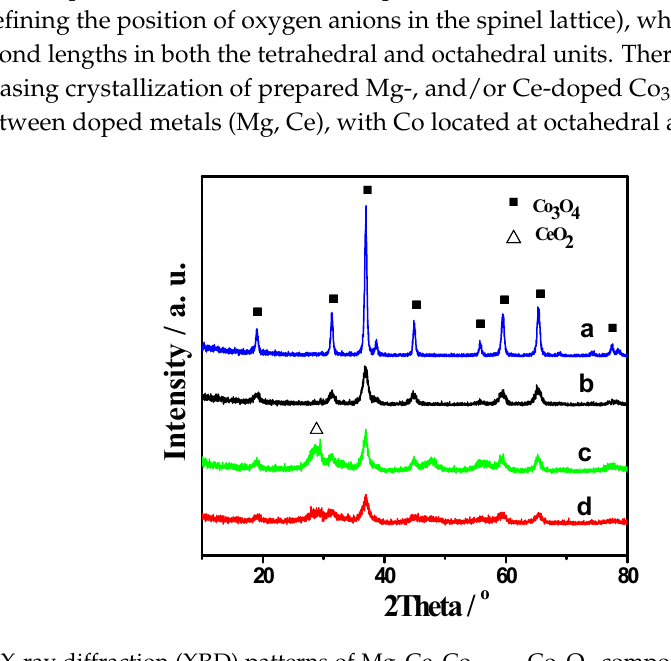
Figure 1. X ‐ ray diffraction (XRD) patterns of Mg x Ce y Co 1 − x − y Co 2 O 4 composite spinel metal oxide: ( a ) Co 3 O 4 ; ( b ) Mg 0.2 Co 0.8 Co 2 O 4 ; ( c ) Ce 0.05 Co 0.95 Co 2 O 4 ; ( d ) Mg 0.025 Ce 0.05 Co 0.925 Co 2 O 4 . Table 1. Brunauer–Emmett–Teller (BET) specific surface area and crystal size of the catalysts.